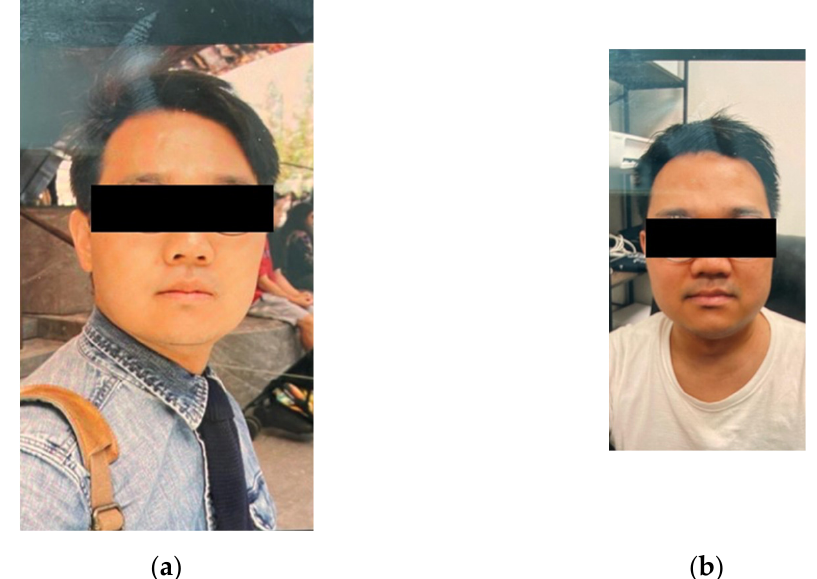
Figure 1. The patient’s progression of moon facies, ( a ) photo from 2019 after initial weight loss ( b ) photo from office visit in 2022.